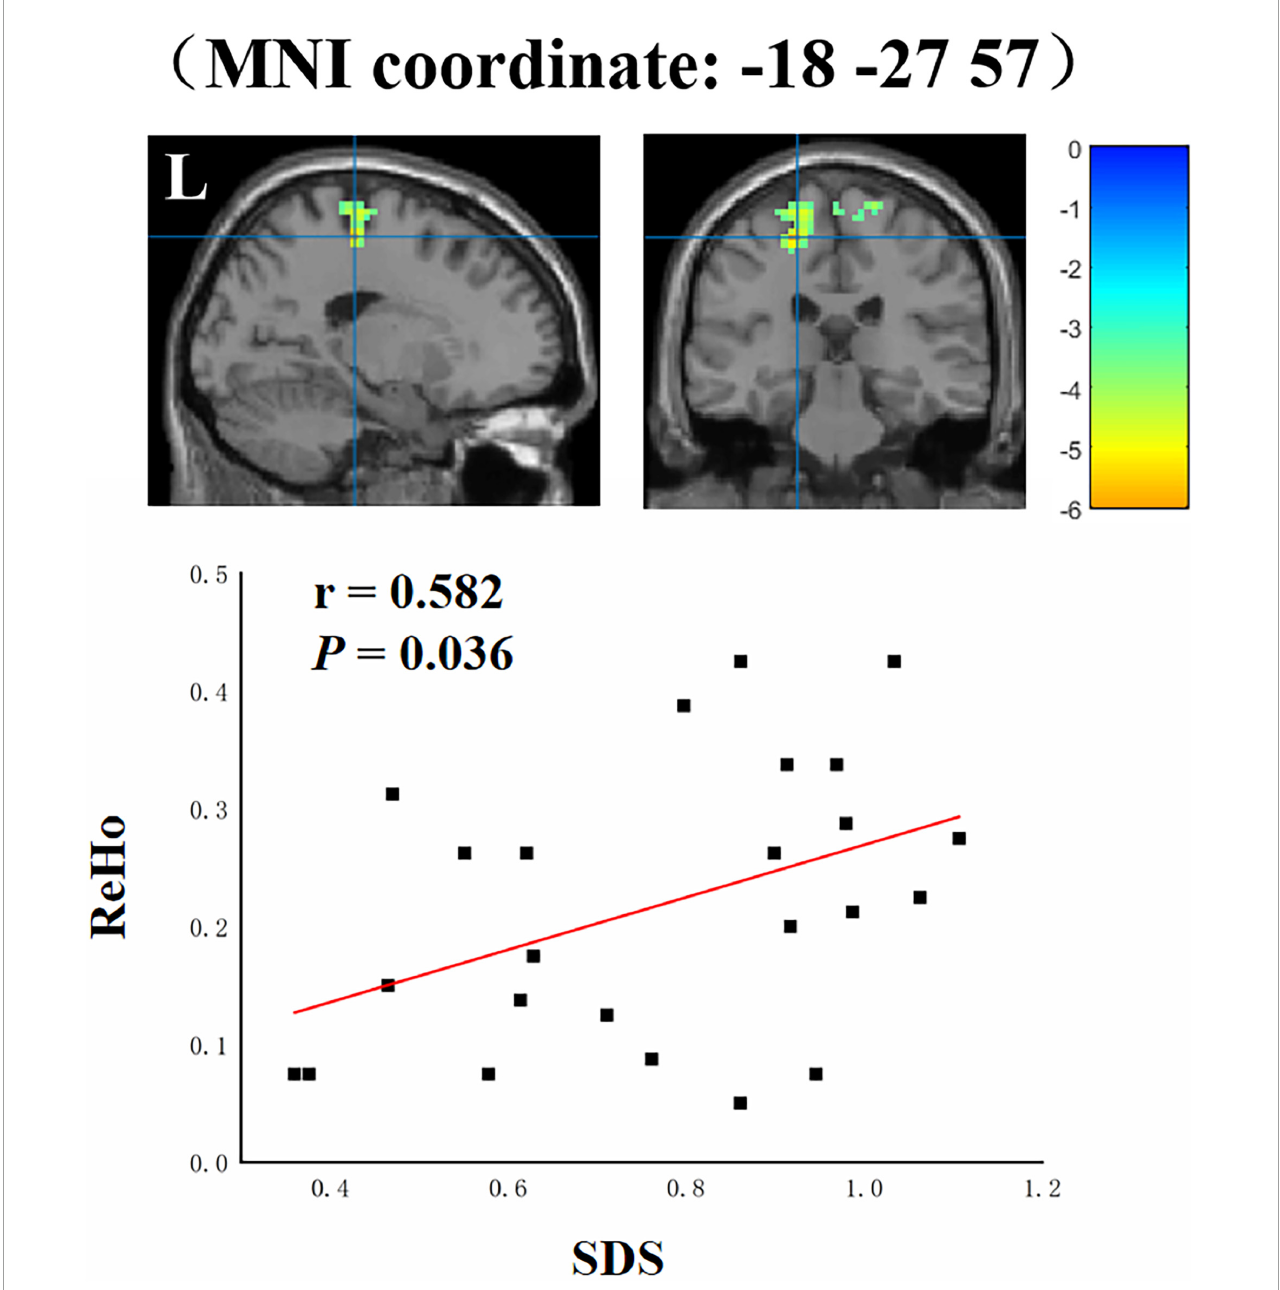
FIGURE3 Correlations between ReHo values and SDS scores in overseas students. L,